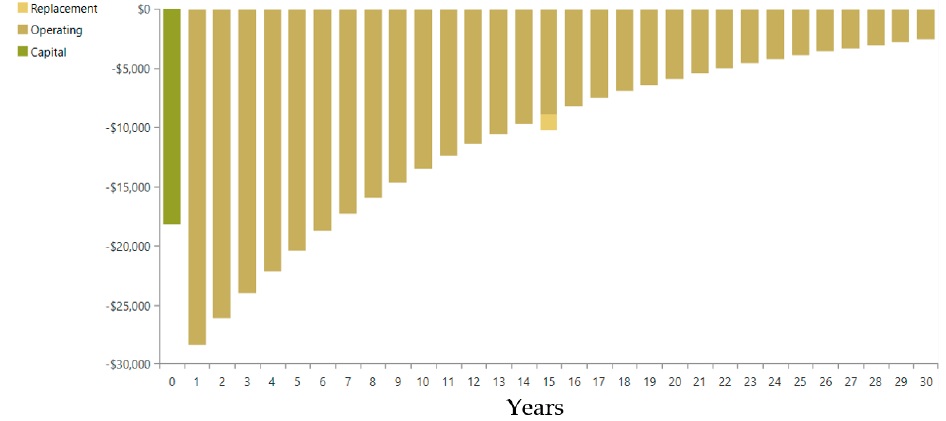
Figure 11. Discount cash flow over the planning study for option 3.